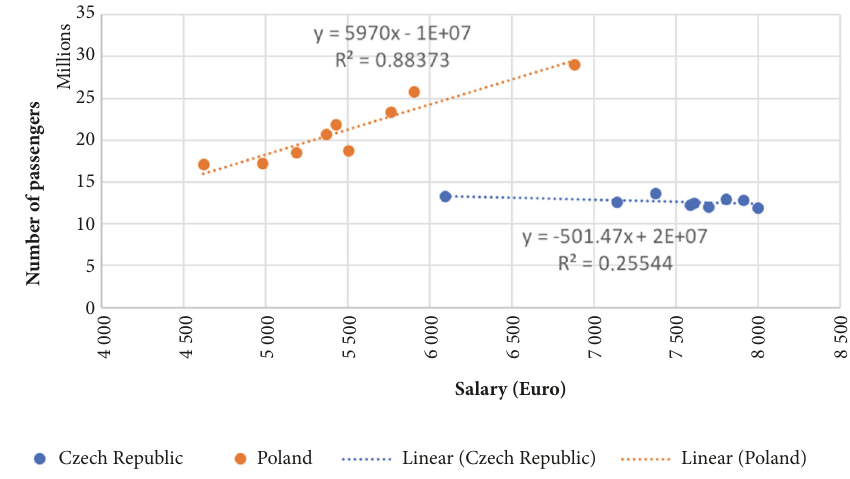
Figure 4: Salary over the years in the Czech Republic and Poland. Linear function is presented to guide the eyes.